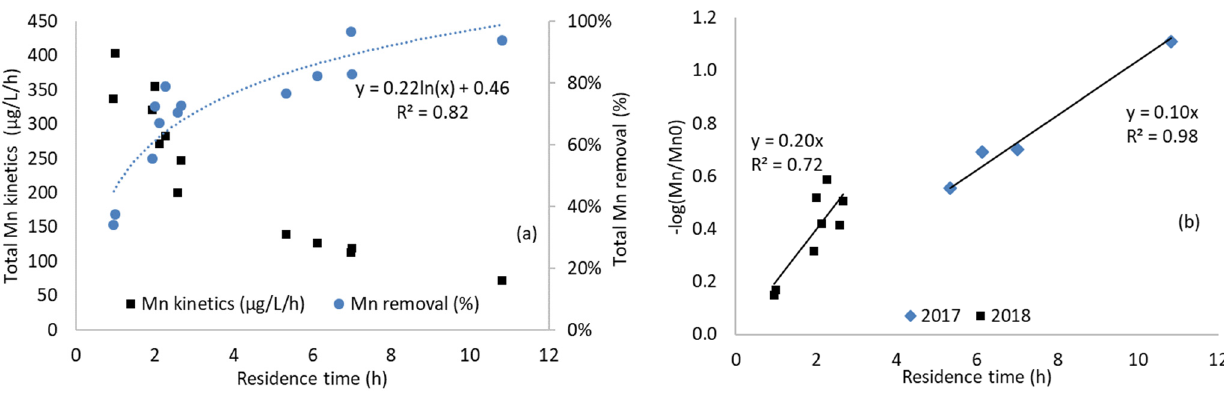
Figure 6. Mn removal kinetics (based on total reactor volume) and total Mn removal (not filtered) vs. HRT in biofilter ( a ). The first three values at the start of the biofilter functioning have been removed; and linear regression of -log(Mn/Mn0) versus HRT (intercept through 0 imposed), y = first order Mn(II) oxidation rate constant ( b